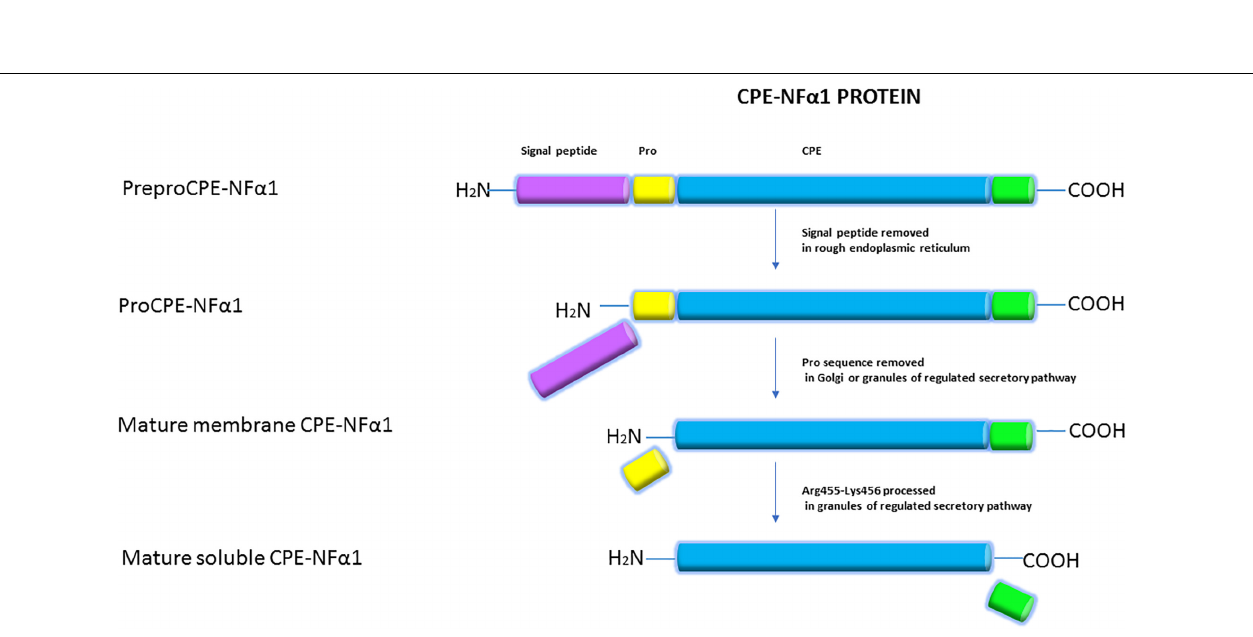
FIGURE 2 | Synthesis of CPE-NF α 1. CPE-NF α 1 is synthesized as preproCPE-NF α 1 which contains a 25-amino acid signal peptide. In the cisternae of rough endoplasmic reticulum, the signal peptide is removed. Then, the 17-amino acid pro peptide is cleaved in the Golgi complex or granules of the regulated secretory pathway. Further processing at Arg455-Lysine 456 produces a soluble form of CPE-NF α 1, with the unprocessed form being membrane associated.